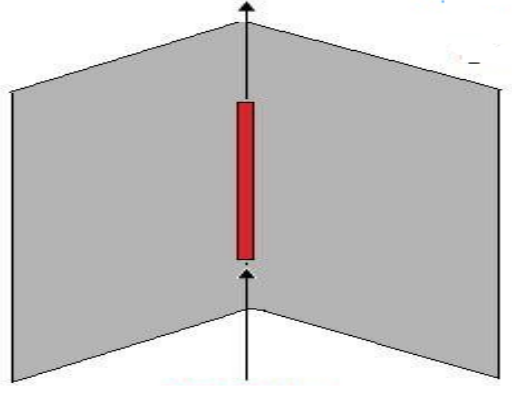
Figure 7. Corner reflector antenna